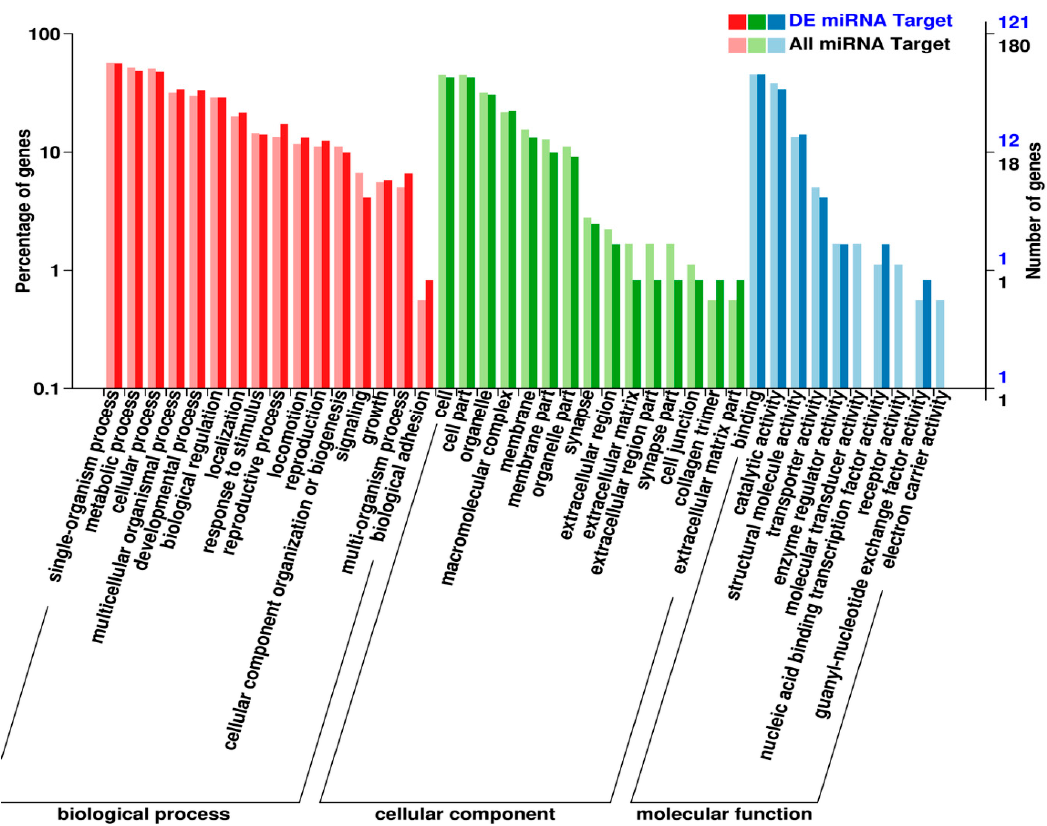
Figure 8. Gene ontology (GO) analysis of miRNA targets in M. incognita . DE miRNA target: Protein coding genes targeted by differentially expressed miRNAs. All miRNA target: Protein-coding genes targeted by all expressed miRNAs.